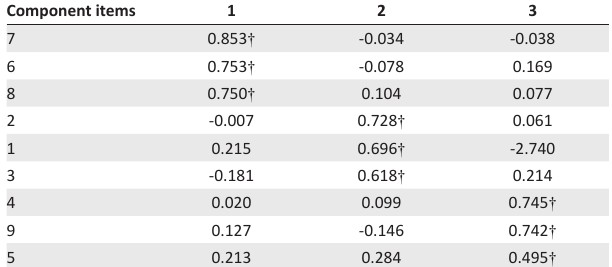
TABLE 2: Pattern matrix for principal components analysis with Oblimin rotation of three-factor solution. Component